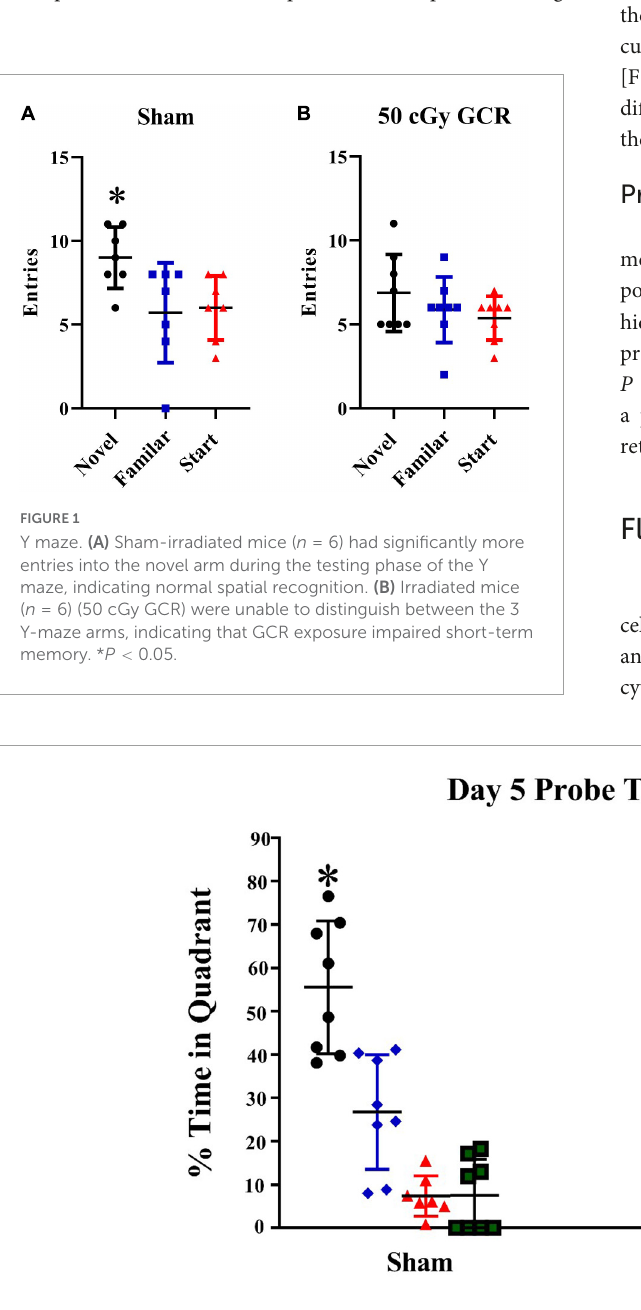
FIGURE2 Spatial memory retention during probe trials on day 5 of Morris water maze testing. During the day of probe trials, the sham-irradiated group ( n = 6) showed significant preference for the target quadrant; whereas, the irradiated group ( n = 6) (50 cGy GCR) was unable to differentiate the target quadrant. * P <